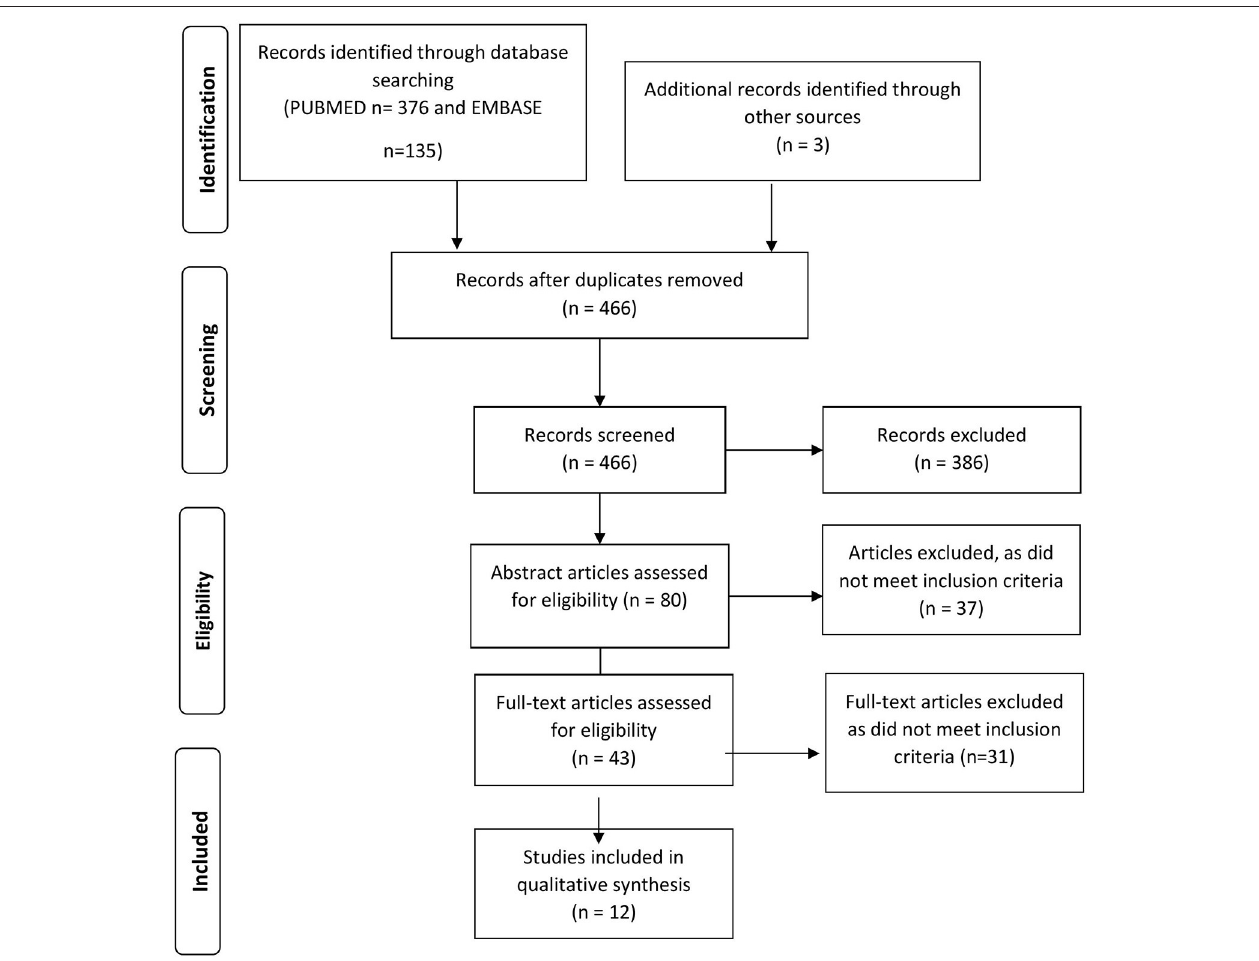
FIGURE 1 | PRISMA flow diagram of search